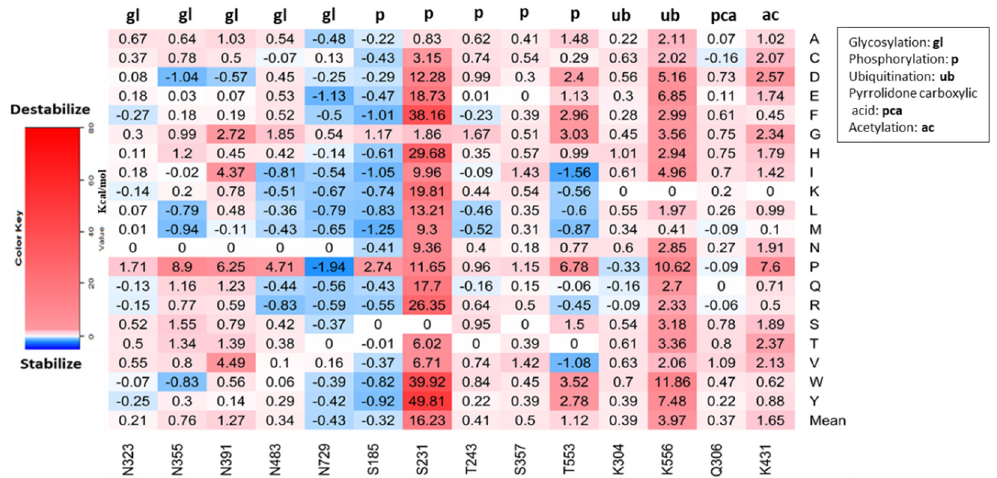
Figure 6. Post − translational modification sites on MPO showing calculated folding energy changes (ΔΔG) for all possible reference residues. Legends are inset.